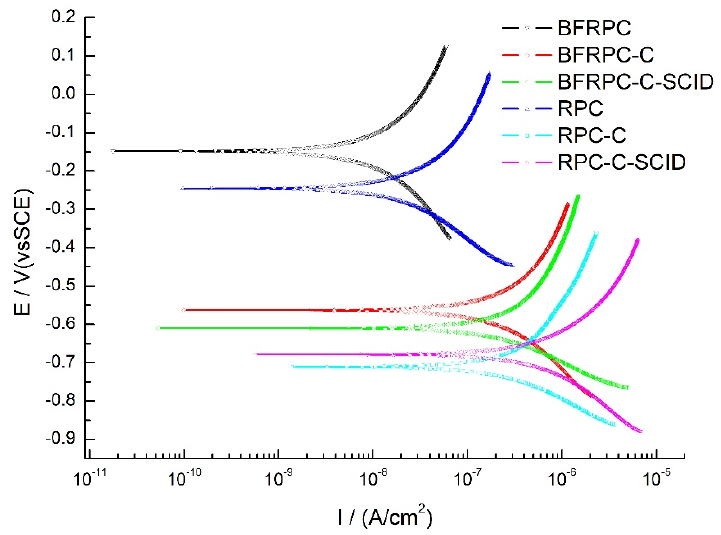
Figure 7. Tafel curves of all specimens (chloride ion penetration time: 7d).